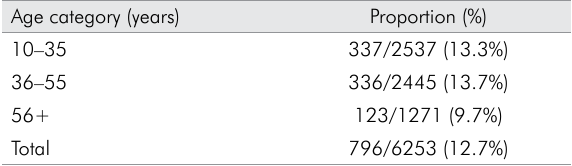
Table 4. Number of teeth with two root canals and the sample size (all examined teeth) in different age categories, and statistical comparisons between categories.